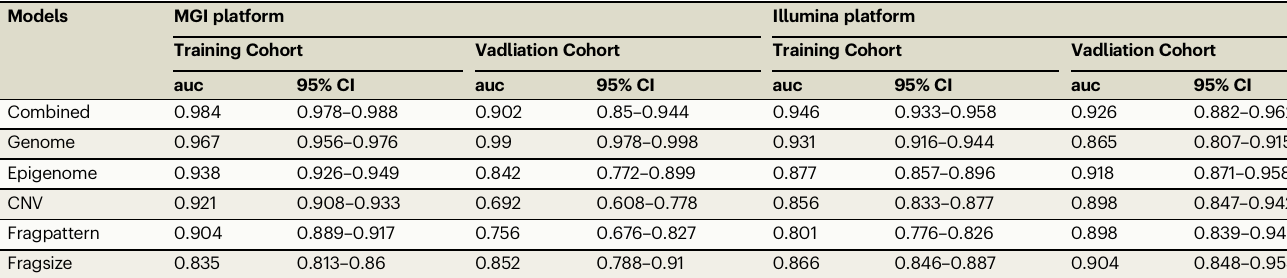
Table 1 | Model performance of cancer detection